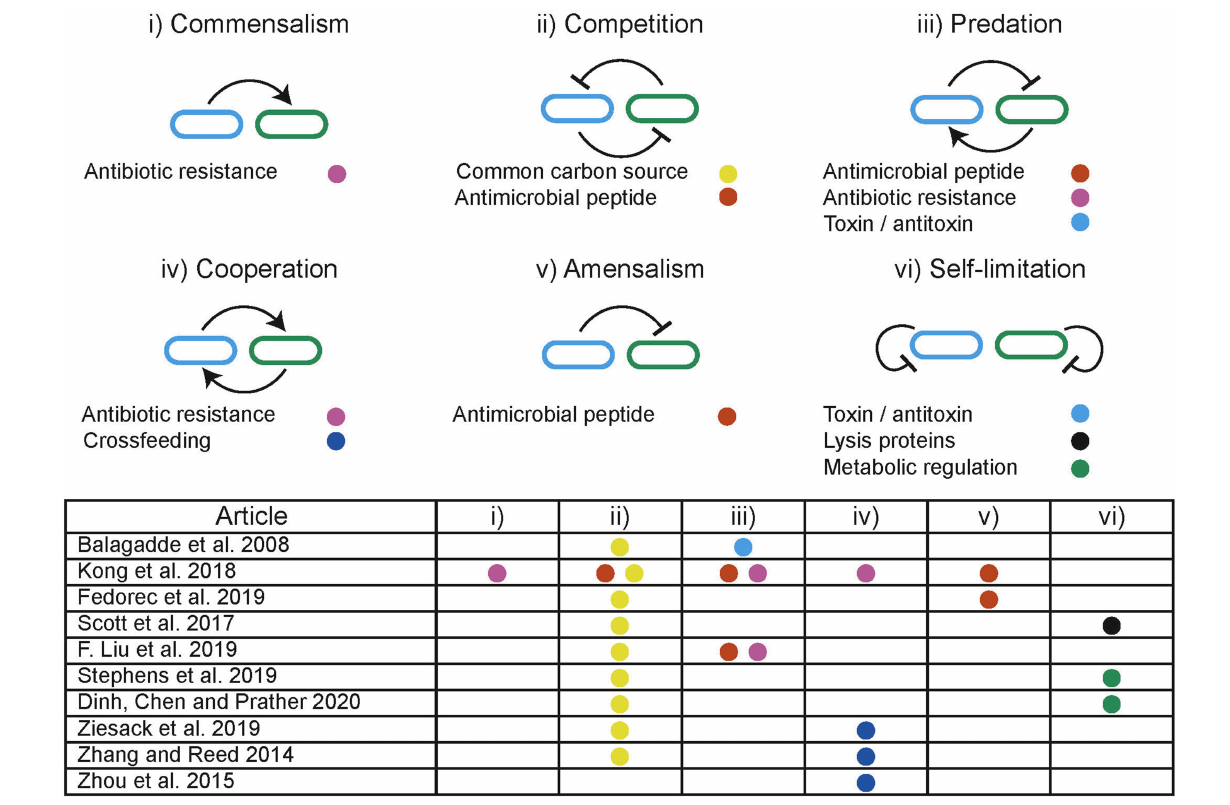
et al., 2002; Hibbing et al., 2010; Freilich et al., 2011;